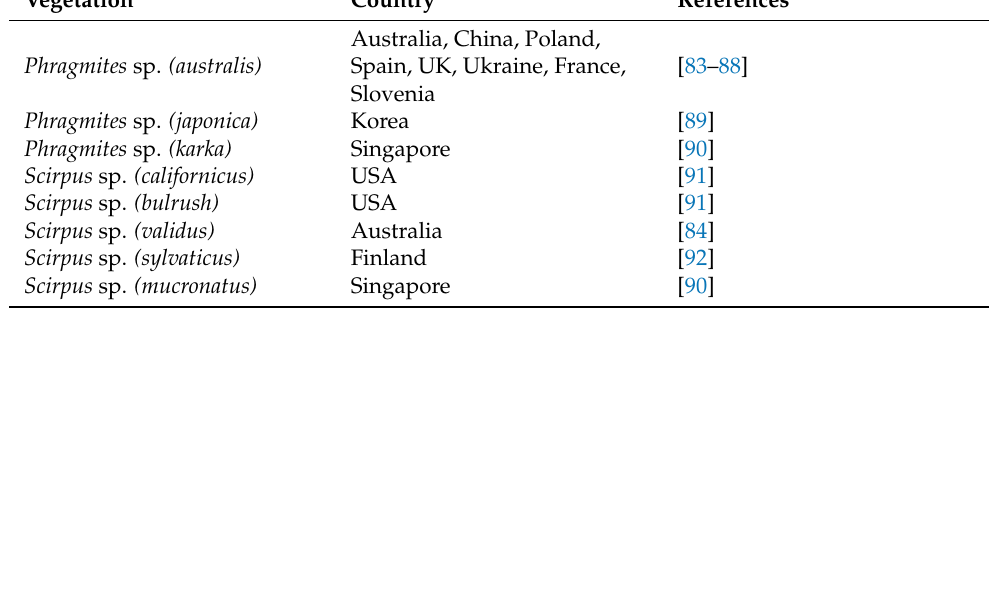
Table 2. Constructed wetland plants for the purification of N and P from agricultural runoff.